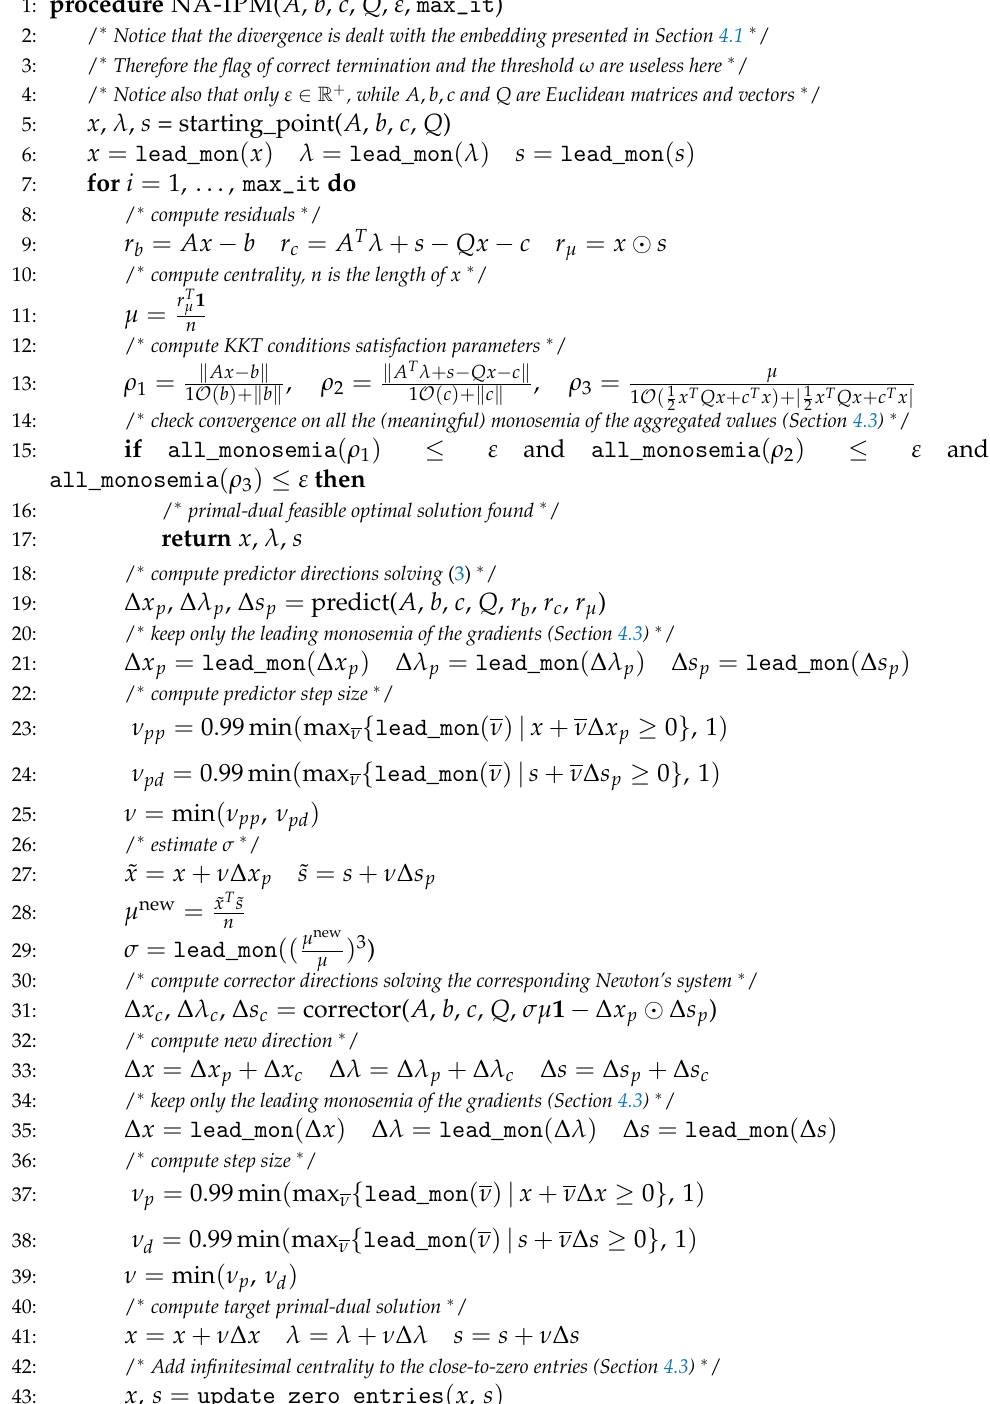
Algorithm 3 Non-Archimedean predictor–corrector infeasible primal-dual